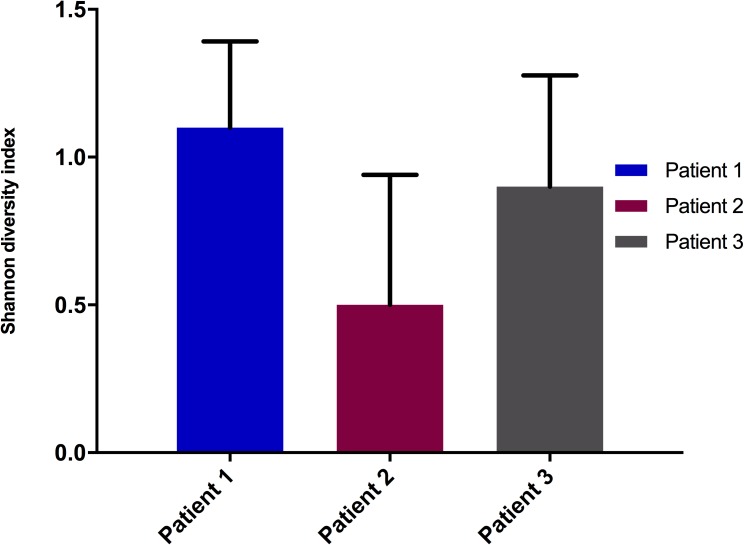
Shannon diversity indices of the three patients at the genus level from meta-sequencing data.